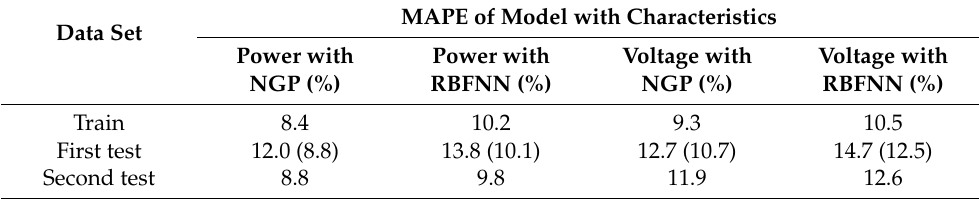
Figure 8. RBFNN and voltage characteristic model cycle life prediction. ( a ) Comparison of observed life and predicted life, ( b ) the cycle life predicted curve. Table 1. Comparison of battery cycle life prediction performance.